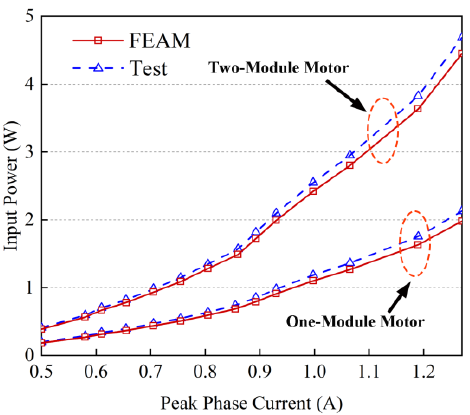
Figure 9. Input power comparison of the one-module motor and two-module motor varying with peak phase current.